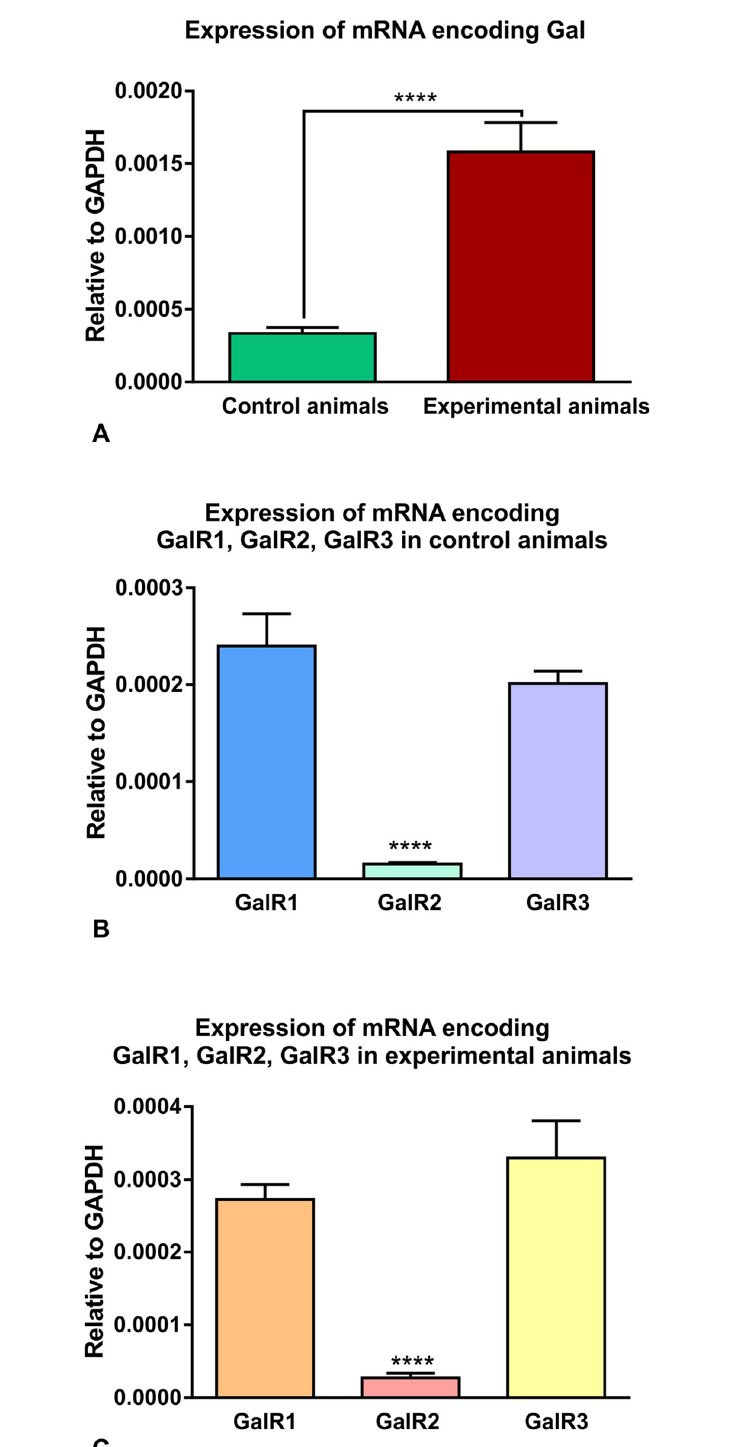
Fig 5. Relative expression of mRNA encoding Gal, GalR1, GalR2, GalR3 in the nodose ganglia of the control and experimental animals. Set of graphs showing the relative expression (to GAPDH as a housekeeping gene) of mRNA encoding galanin ( A ) and galanin (GalR1, GalR2, GalR3) receptors ( B, C ) in the control and experimental animals. The expression of galanin was markedly increased in experimental animals in relation to controls ( A ). GalR2 was significantly less expressed in relation to GalR1 and GalR3 in the group of control ( B ) and experimental ( C ) animals. ( ���� p < 0.0001; error bars indicate SEM).